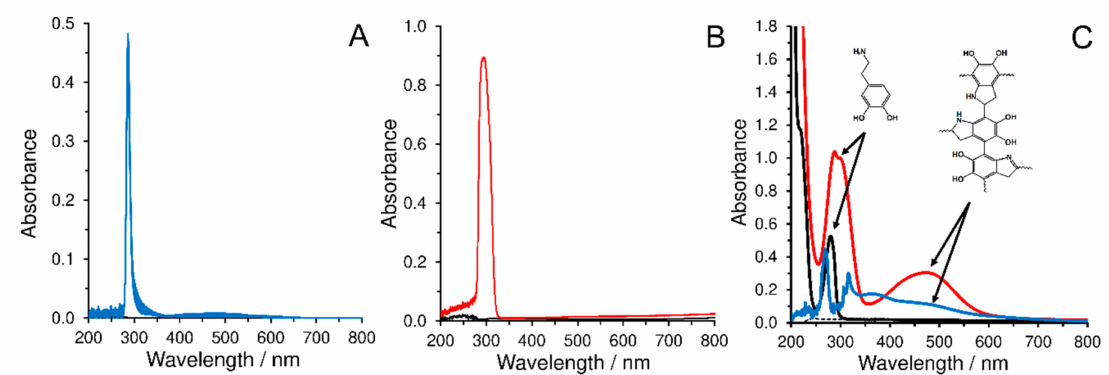
Figure 8. UV-Vis spectra (6 records obtained every 5 min) of 200 µ mol L − 1 dopamine ( A ) and 200 µ mol L − 1 serotonin ( B ) in 0.1 mol L − 1 PB (pH 7.0) with the presence of 500 µ mol L − 1 H 2 O 2 , the spectrophometric records obtained for comparing the catalytic activity of CBCC in presence of H 2 O 2 with that of tyrosinase ( C ), 150 µ mol L − 1 dopamine (black) in the presence of 2 µ g mL − 1 tyrosinase (red) in the comparison with the record obtained for 150 µ mol L − 1 dopamine in the presence of 300 µ mol L − 1 CBCC and 500 µ mol L − 1 H 2 O 2 (blue line). Reaction time of 5 min was used in both